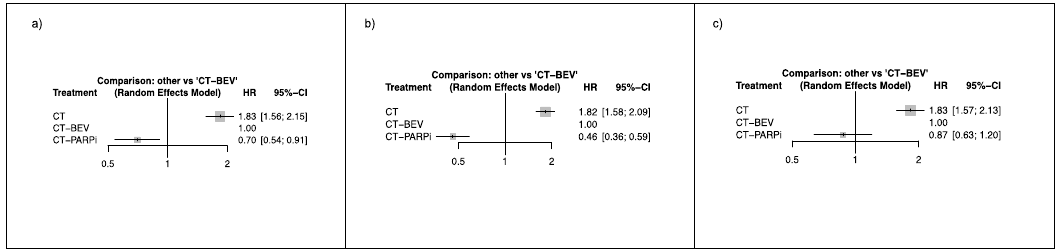
Figure 2. Hazard ratios (HR) of progression-free survival (PFS) for PARPi-based trials (CT-PARPi) as compared with bevacizumab-based trials (CT-BEV) and chemotherapy (CT) alone without maintenance. ( a ) All comers population; ( b ) BRCA mutated; ( c ) BRCA wild type patients.